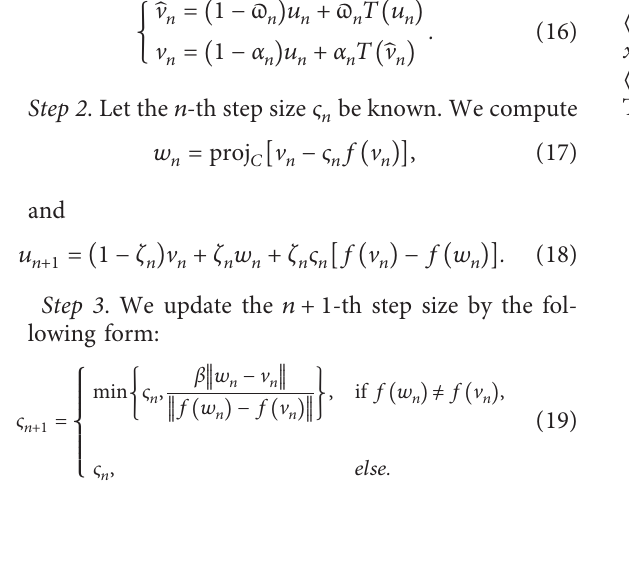
Algorithm 1. Initialization: let u set n �